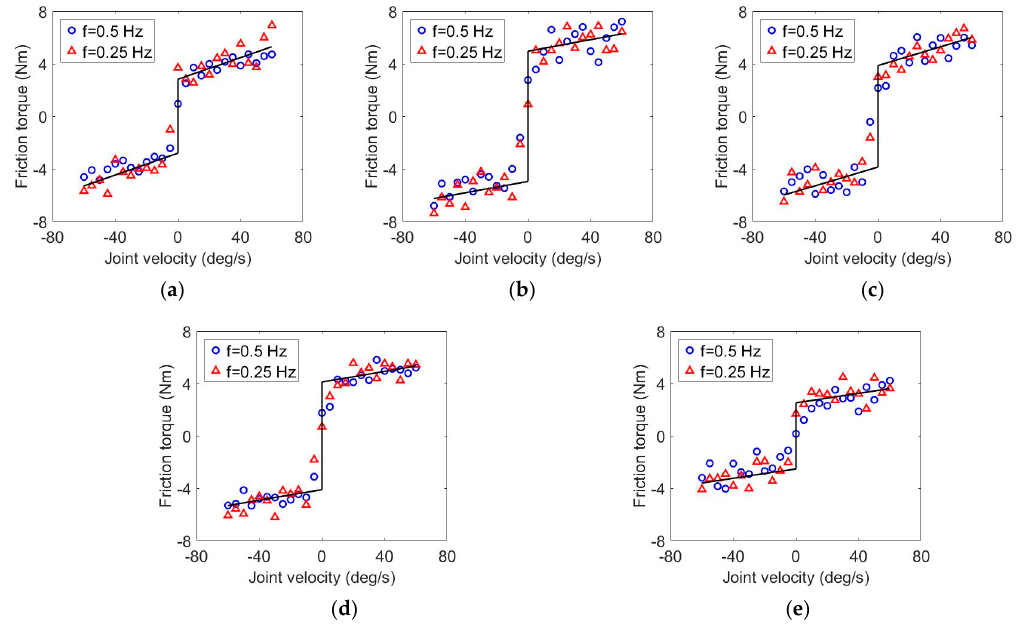
Table 2. Identification results for the parameters of Coulomb-viscous friction models.